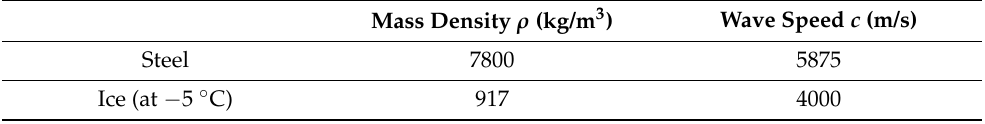
Table 1. Acoustic properties of the turbine blade and ice